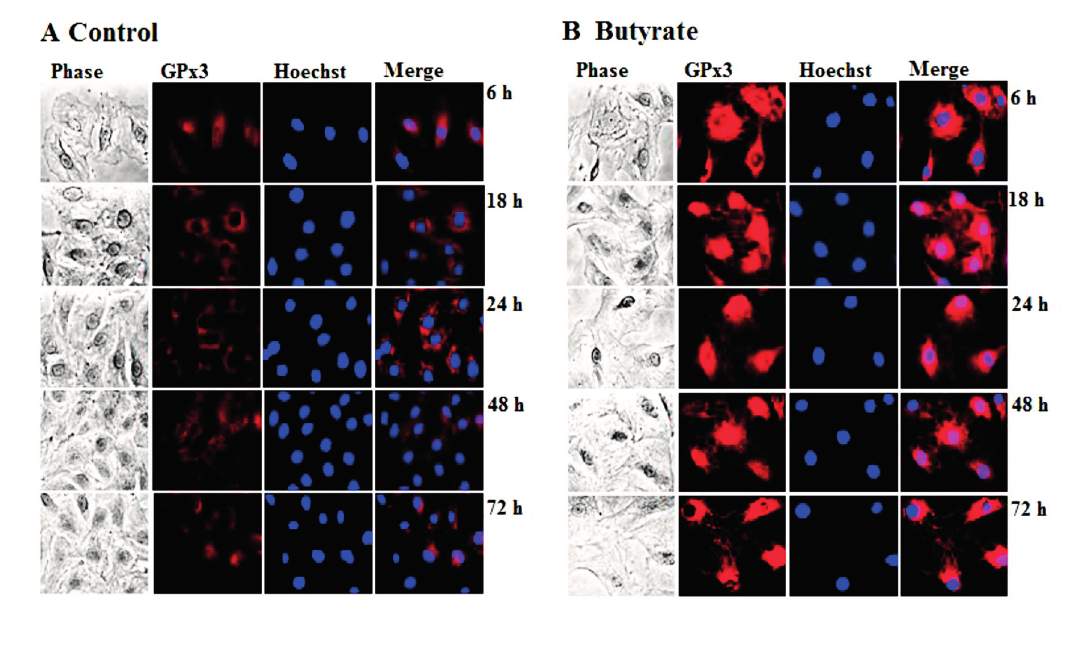
Figure 2. Intracellular localization of butyrate-induced GPx3 expression in VSMC. VSMC untreated ( A ) or treated with 5 mM butyrate ( B ) for different periods of time were fixed and processed for immunostaining of GPx3, as described in the Experimental Section. Images of stained VSMC were captured by a Nikon fluorescence microscope with a CCD camera (400×